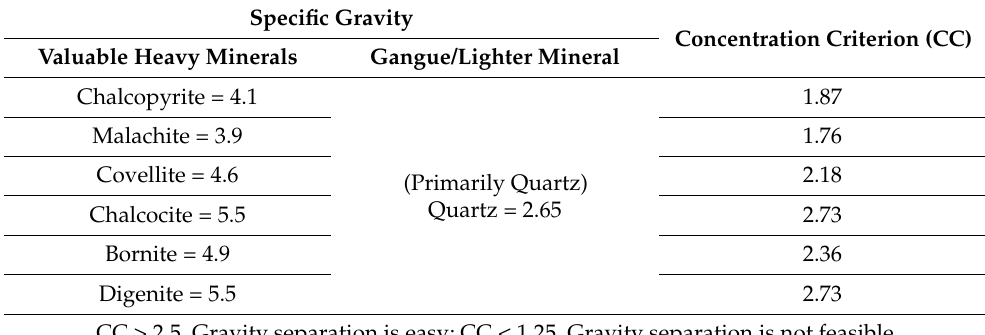
Table 4. Concentration criteria between Malanjkhand constituent